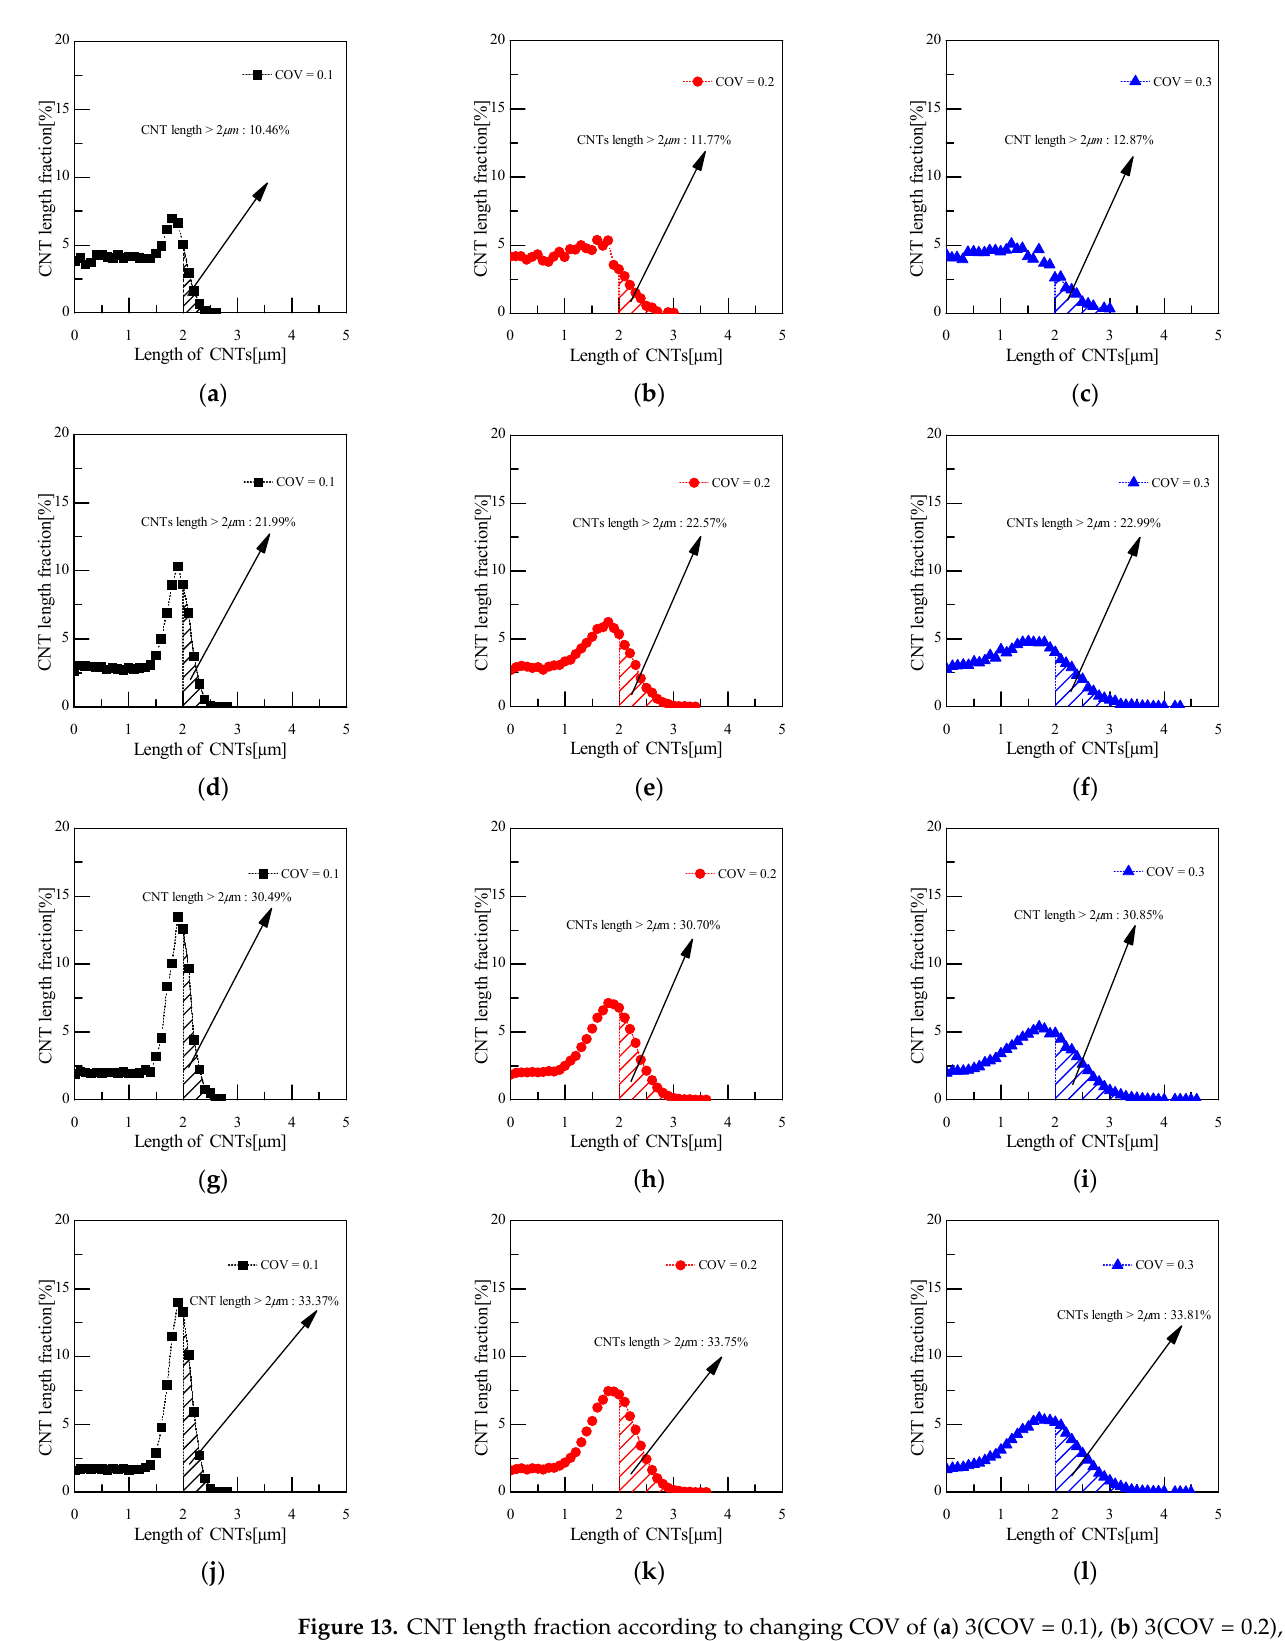
Figure 13. CNT length fraction according to changing COV of ( a ) 3(COV = 0.1), ( b ) 3(COV = 0.2), ( c ) 3, ( d ) 5(COV = 0.1), ( e ) 5(COV = 0.2), ( f ) 5(COV = 0.3), ( g ) 8(COV = 0.1), ( h ) 8(COV = 0.2), ( i ) 8(COV = 0.3), ( j ) 10(COV = 0.1), ( k ) 10(COV = 0.2), and ( l ) 10(COV = 0.3) µm.